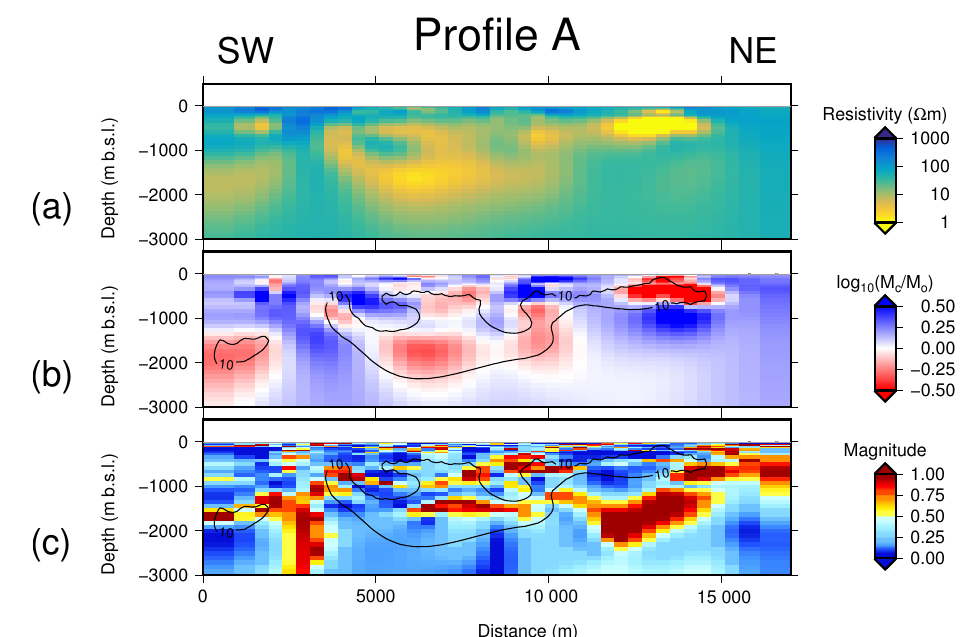
Figure 12. Profile A taken along the axis of the concealed basin through the static-shift-corrected resistivity model M c (location shown in Figs. 1 and 11g). The resistivity is shown in panel (a) , the resistivity difference (cid:49)(M c ,M o ) is shown in panel (b) , and the cross-gradient of M c and M o is shown in panel (c) . Contours on the difference and cross-gradient plots show the 10 (cid:127) m contour. For presentation a vertical exaggeration of 1.5 is used.